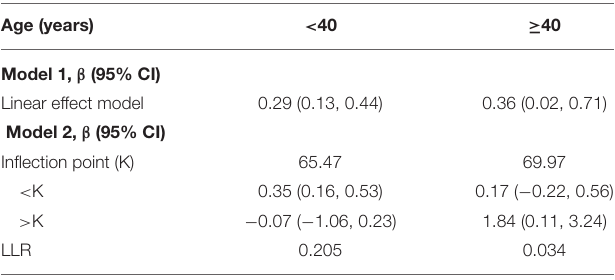
Age (years) Model 1, β (95% CI)